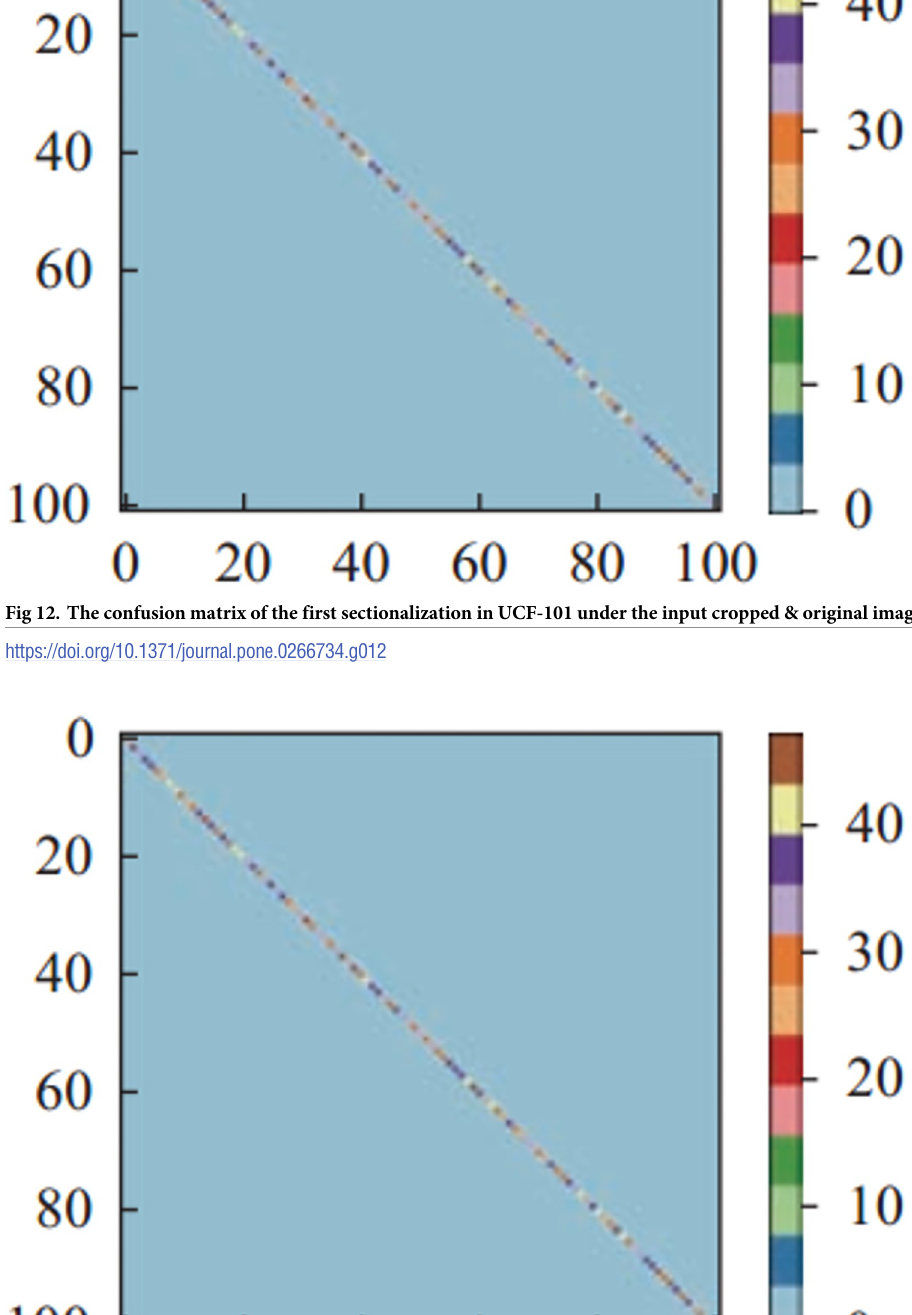
PLOS ONE | https://doi.org/10.1371/journal.pone.0266734 August 1,